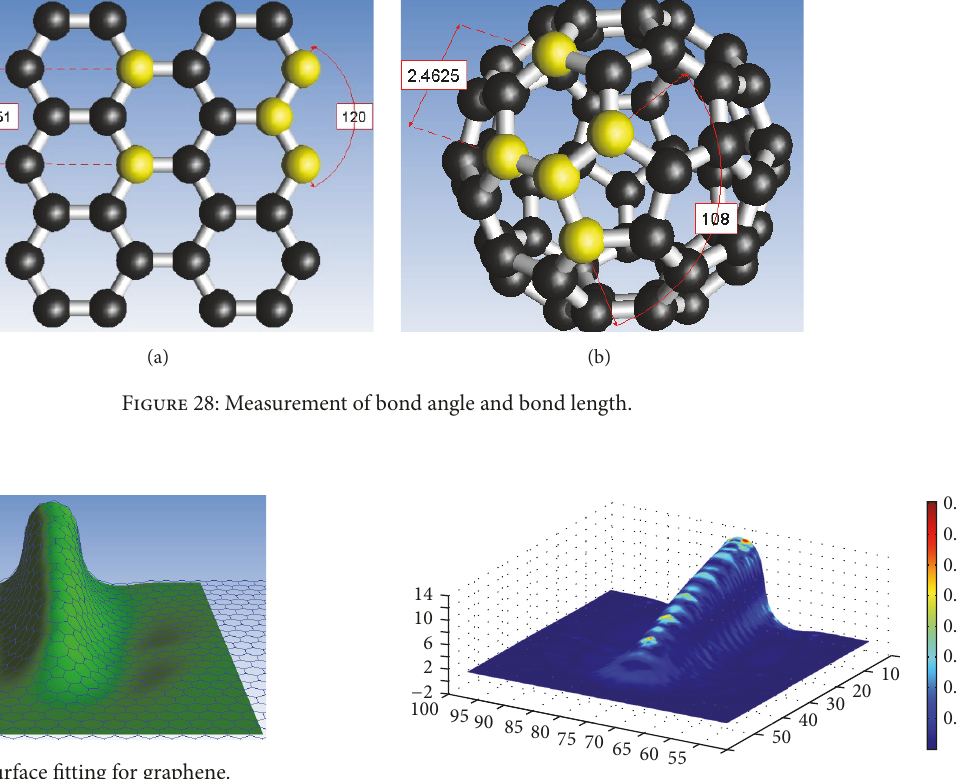
Figure 30: Curvature calculation for